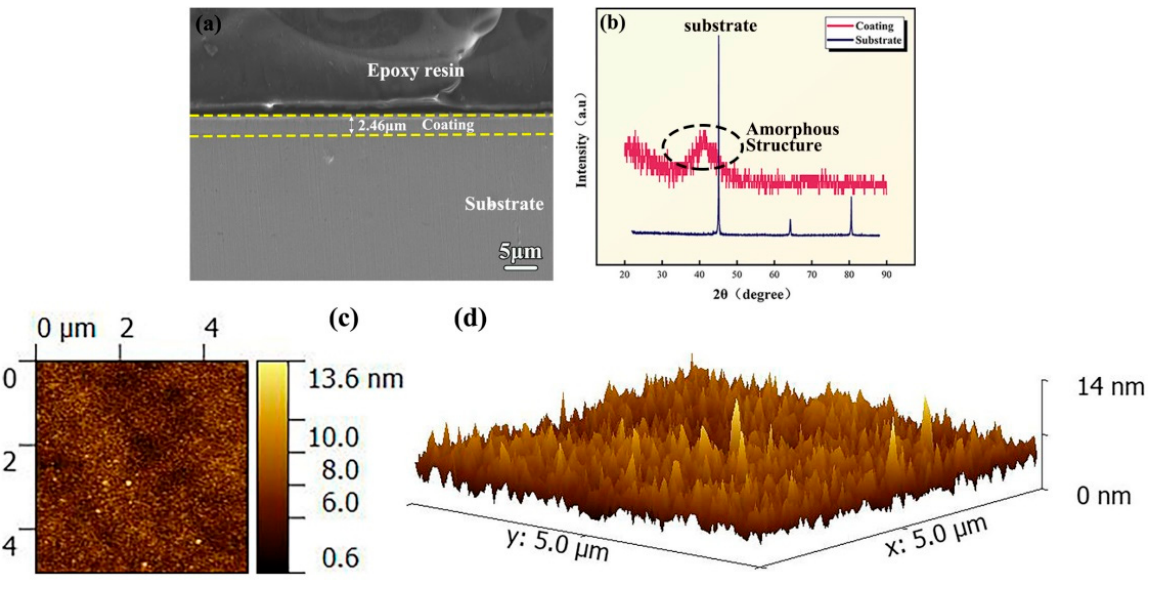
Figure 4. ( a ) Cross sectional morphology image of the as − deposited AlTiCrFeMoSi HEA coating: ( b ) XRD pattern of as − deposited AlTiCrFeMoSi coating; ( c , d ) surface AFM 2D and 3D morphology.